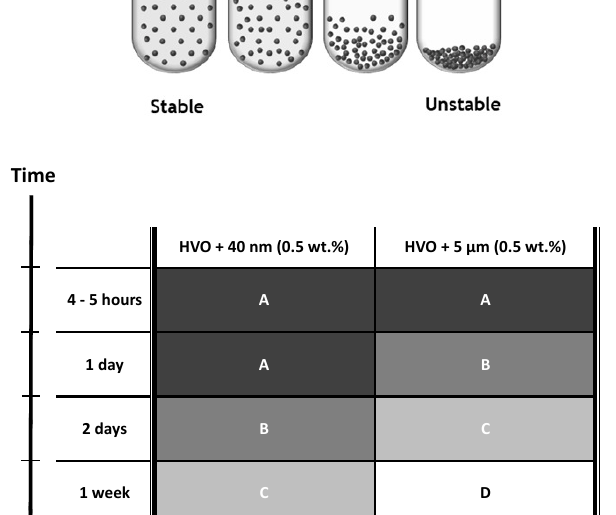
Figure 4. Stability study.